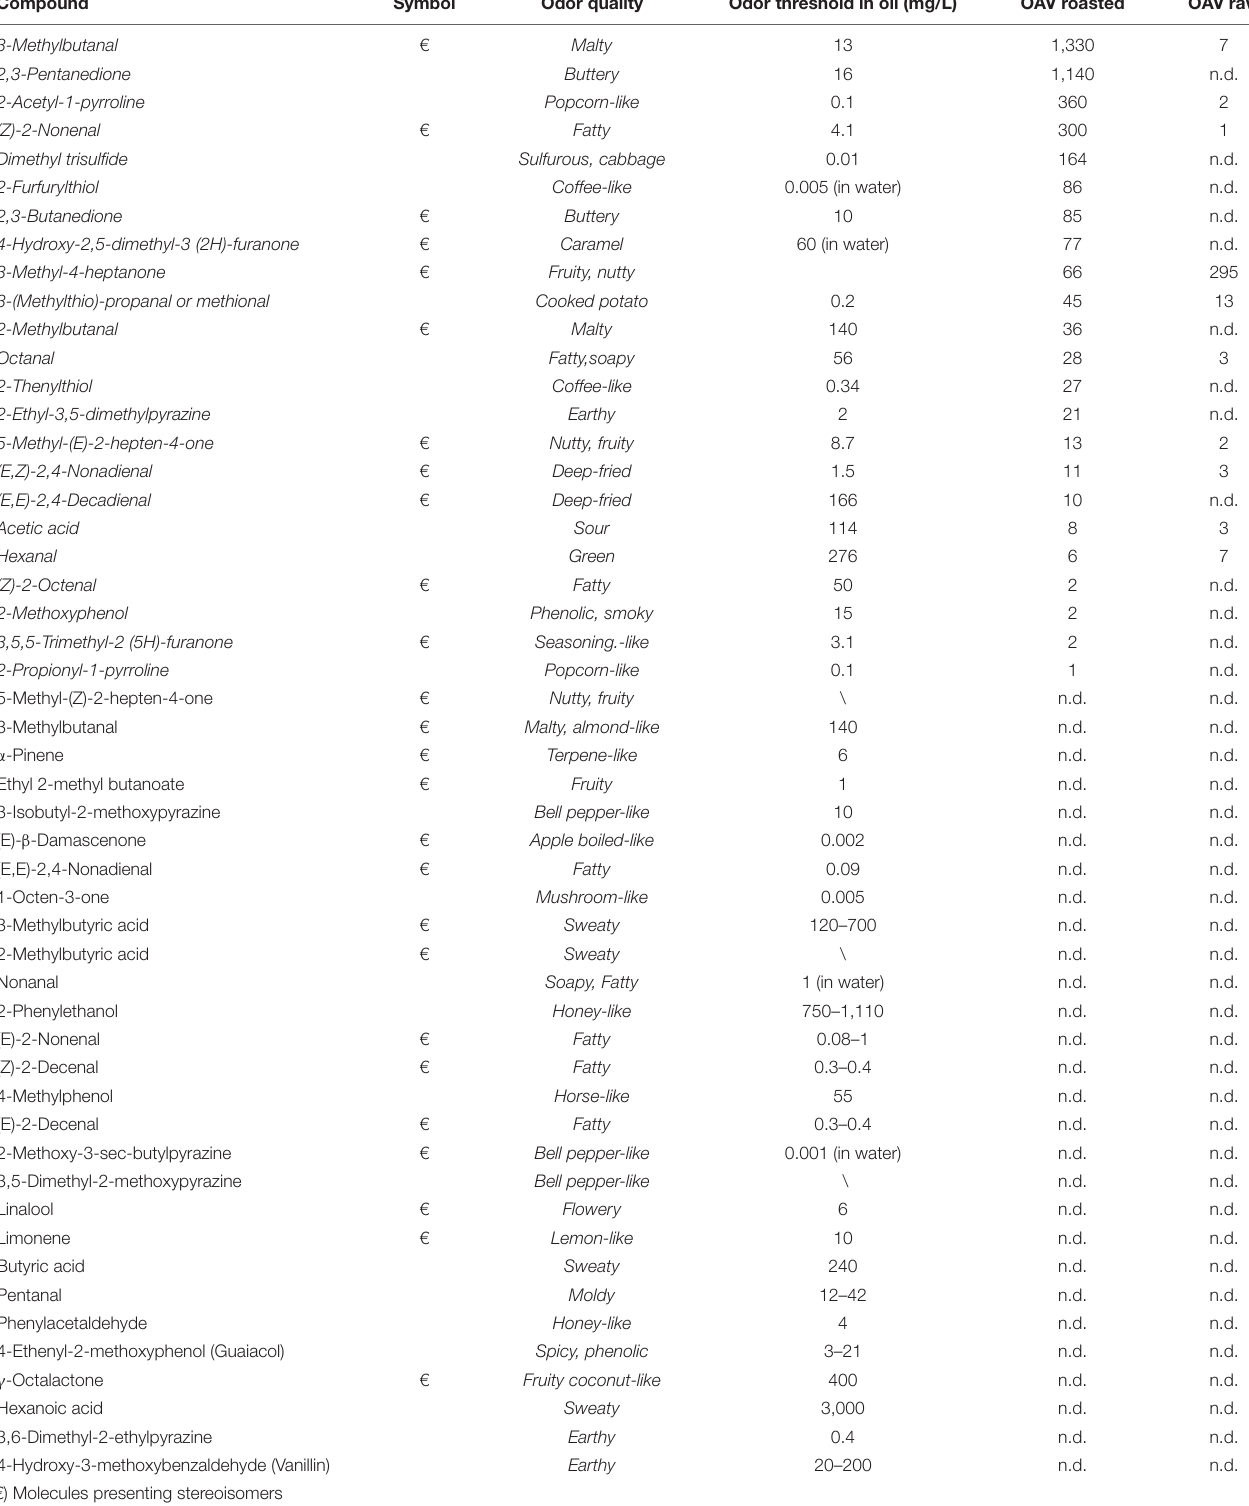
TABLE 1 | Potent odorants identified in raw and roasted Italian hazelnuts (cultivar Tonda Gentile Romana ; Burdack-Freitag and Schieberle, 2010) with estimated OAVs according to Kiefl and Schieberle (Kiefl and Schieberle, 2013; Kiefl et al., 2013). Compound Symbol Odor quality Odor threshold in oil (mg/L) OAV roasted OAV